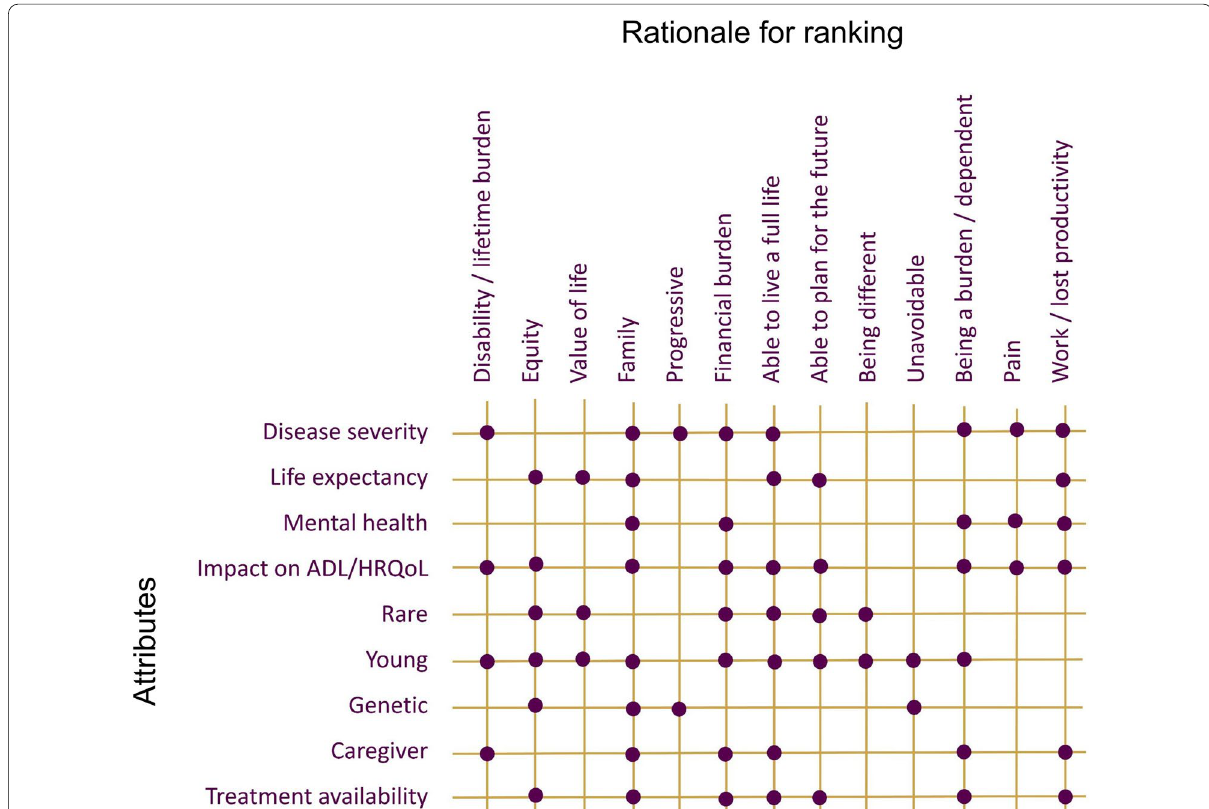
Fig. 3 Patterns in rationales for ranking different attributes important for research and treatment